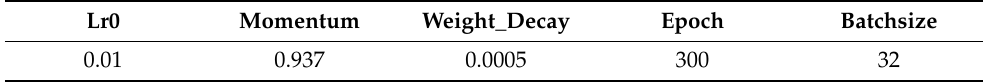
Table 2. Network parameters of MR-YOLO.